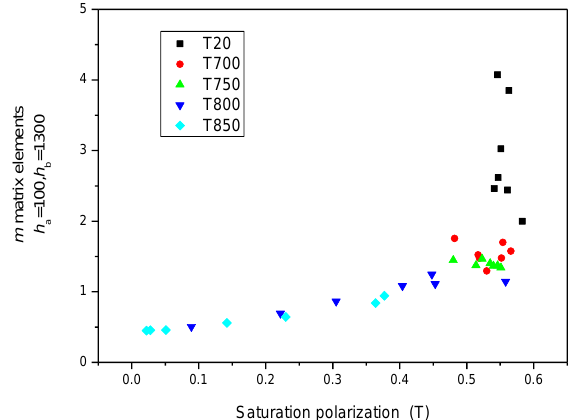
Figure 14. ( h a = 100 and h b = 1300) m matrix elements for all samples, indicating the actual heat treatments as functions of the saturation polarization.